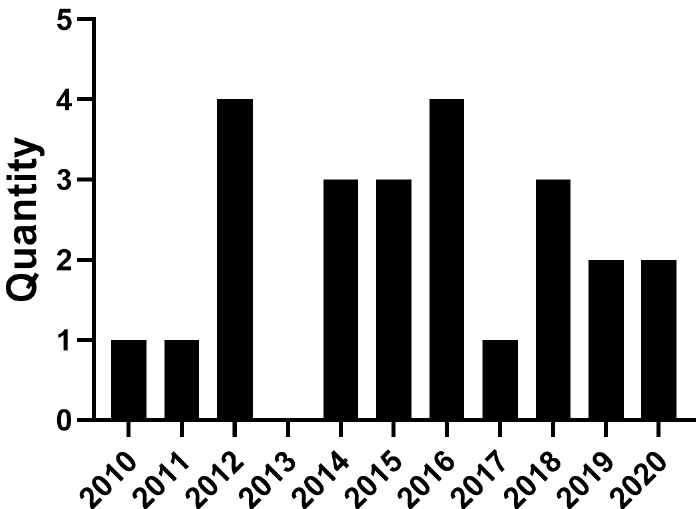
Figure 1. Number of studies related to IoT and mental health published per